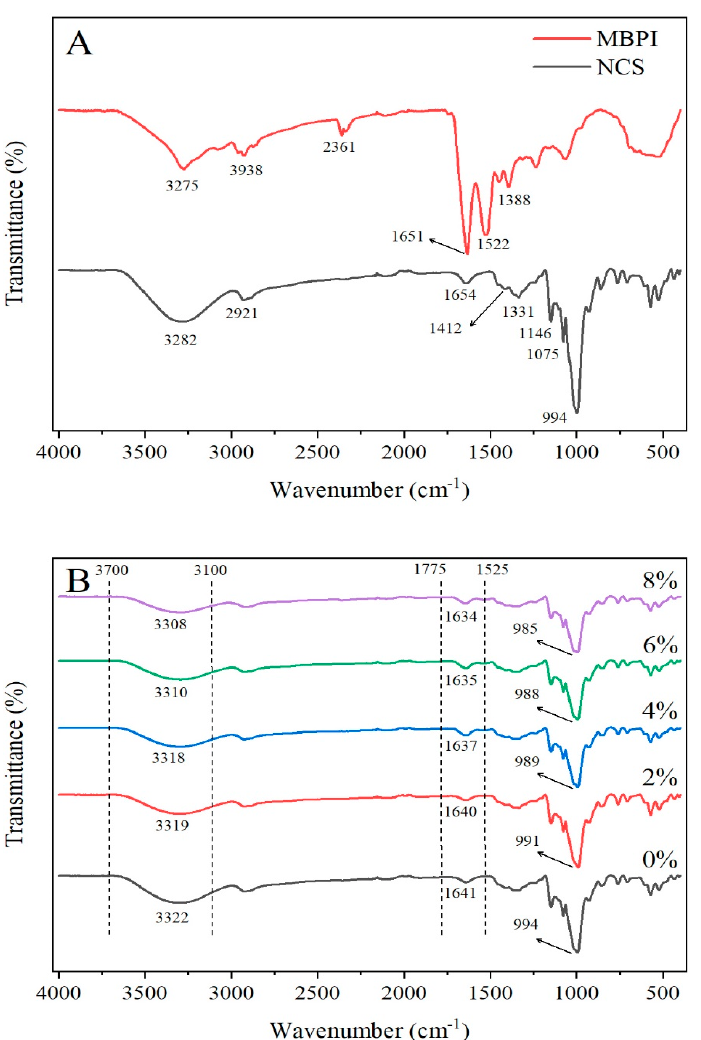
Figure 2. FT-IR spectra of NCS and MBPI ( A ) and NCS/MBPI gels, ( B ) at different MBPI concentra- tions (2%, 4%, 6%, and 8%).